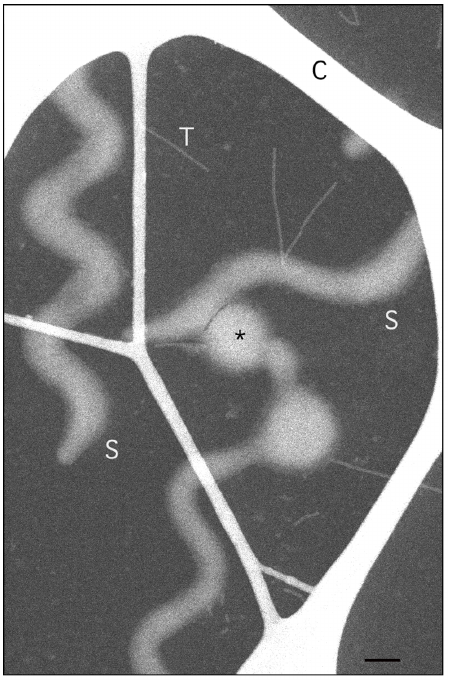
Figure 2. STEM dark field image of freeze-dried, intact Spiroplasma cells. A thick carbon lace (C) supports a thin ( , 3 nm) carbon film. Cells (S) and TMV particles (T), the latter used for mass calibration, are scattered on the carbon support. The cells are polar and have distinct tapered (left edge) or round ends (not seen). Older cells are known to vesiculate, as indicated by the asterisk. Note the difference in mass, as reflected by differences in image brightness, between the straight, uniform tubular cell segments (dimmer) and the heavier (brighter) inflection points of the collapsed coils. Only the straight, uniform segments were used for mass measurements. Scale bar=200 nm.